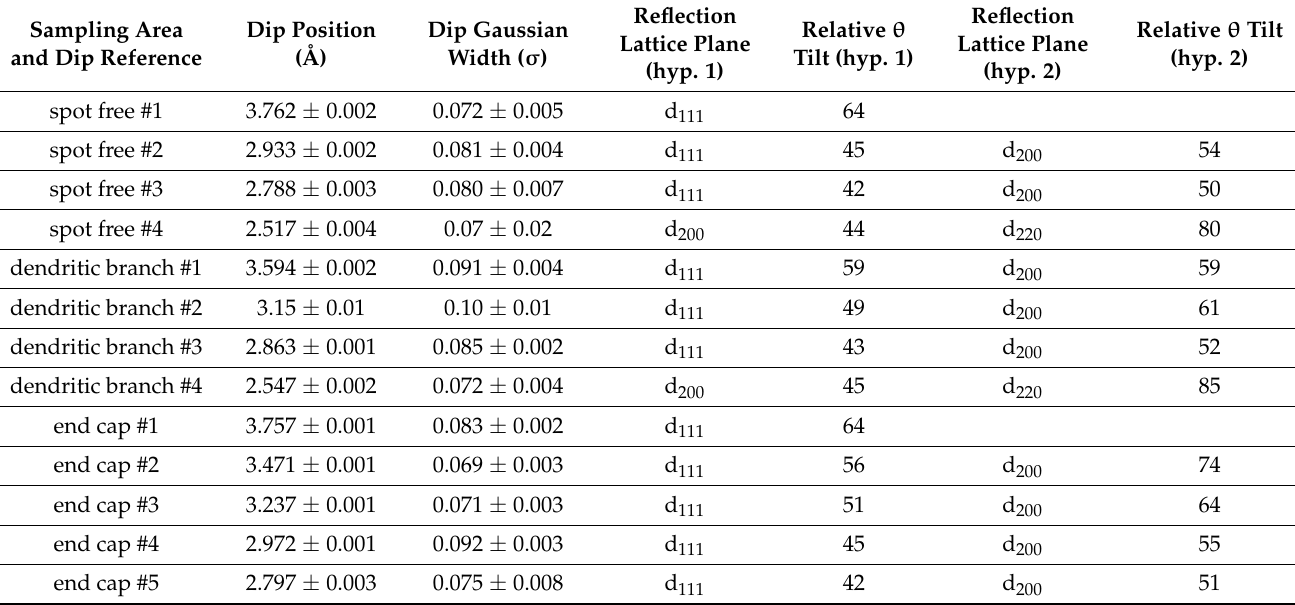
Table 1. Results of the fitting negative Gaussian peak fitting of the dips shown in Figure 2. The reported values are the wavelength, the dip width and the possible relative plane families originating the scattering, including the scattering angle values as obtained by the Bragg law taking into account the ideal pure Cu lattice parameter, 3.6147(2) Å. Sampling